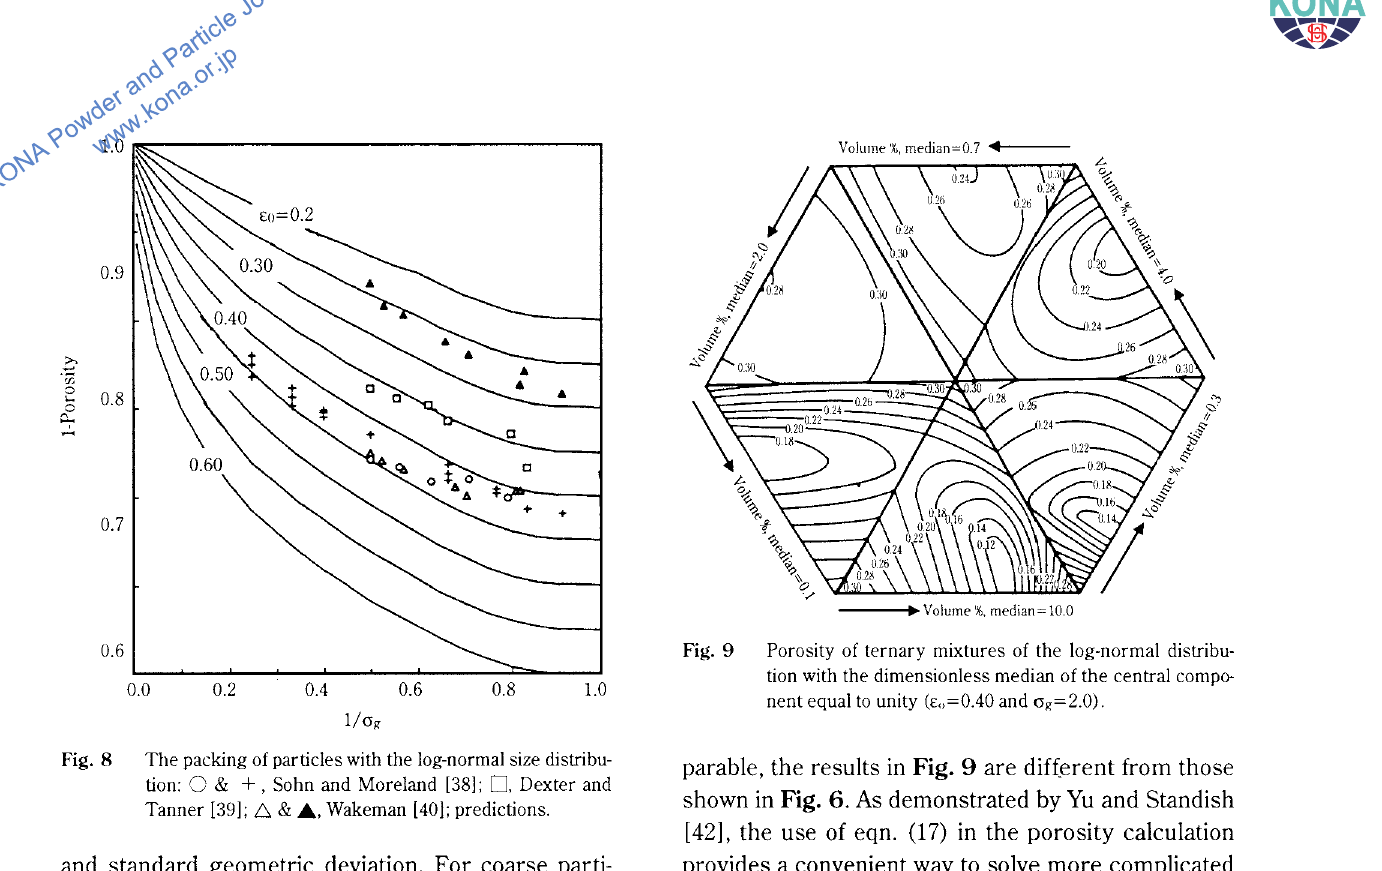
The packing of particles with the log-normal size distribu tion: 0 & +, Sohn and Moreland [38]; D. Dexter and Tanner [39]; D. & A. Wakeman [40]; predictions.